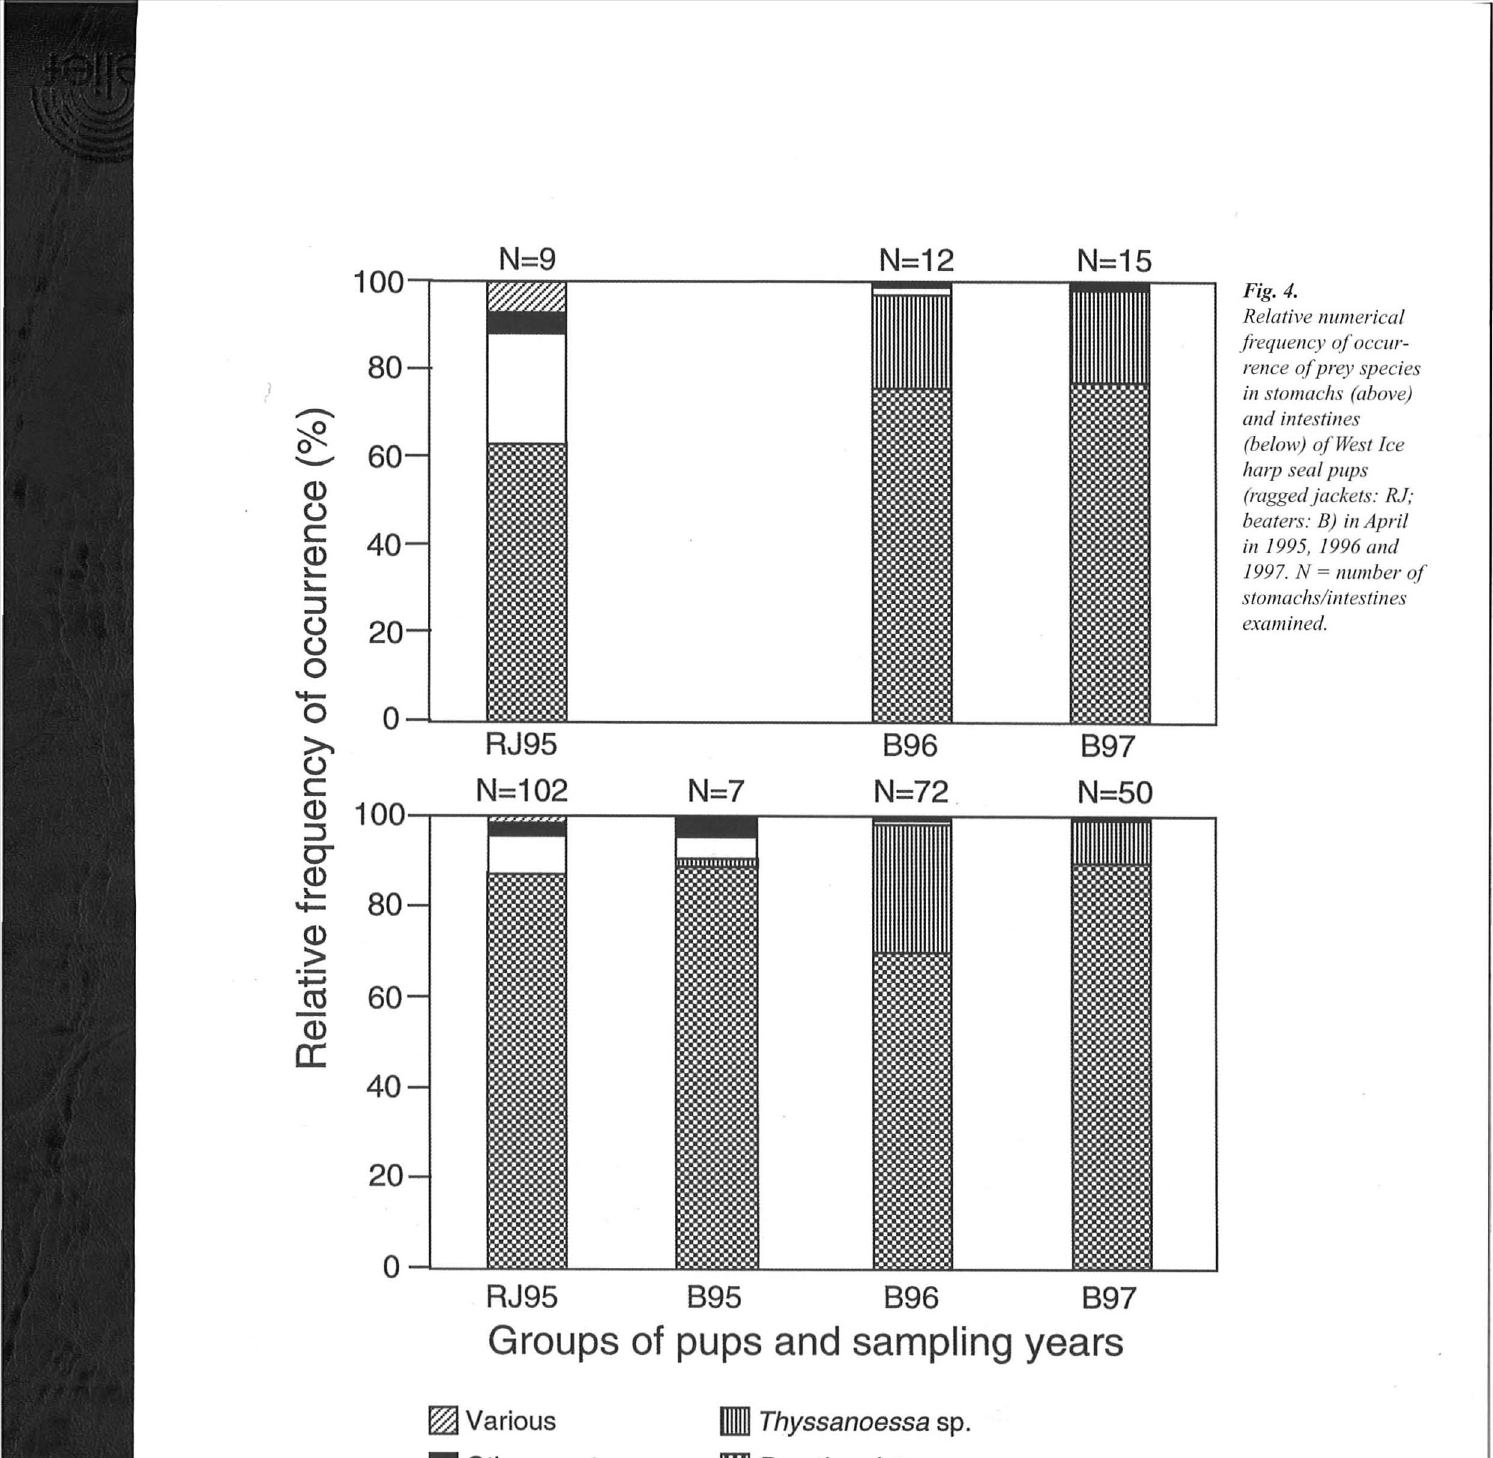
Fig. 4. Relative lIulI/erical frequellcy of occur rellce of prey species and